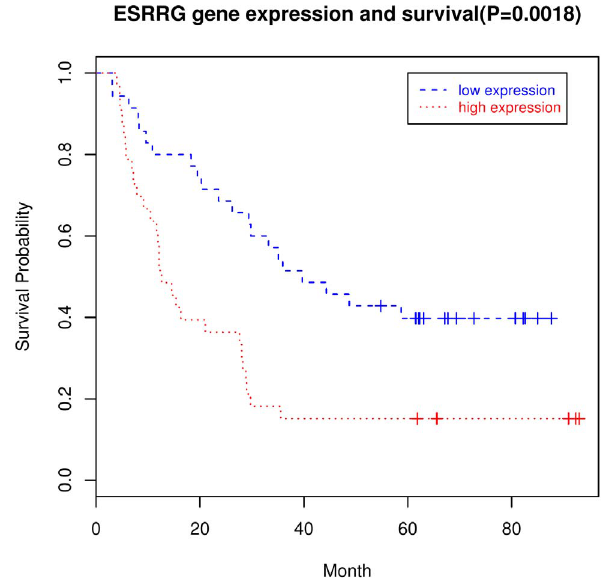
Figure 6. Survival curve for ESRRG in GNCA by Kaplan-Meier analyses. Dotted red lines indicate high (above the median) expression and broken blue lines indicate low (below the median) expression.